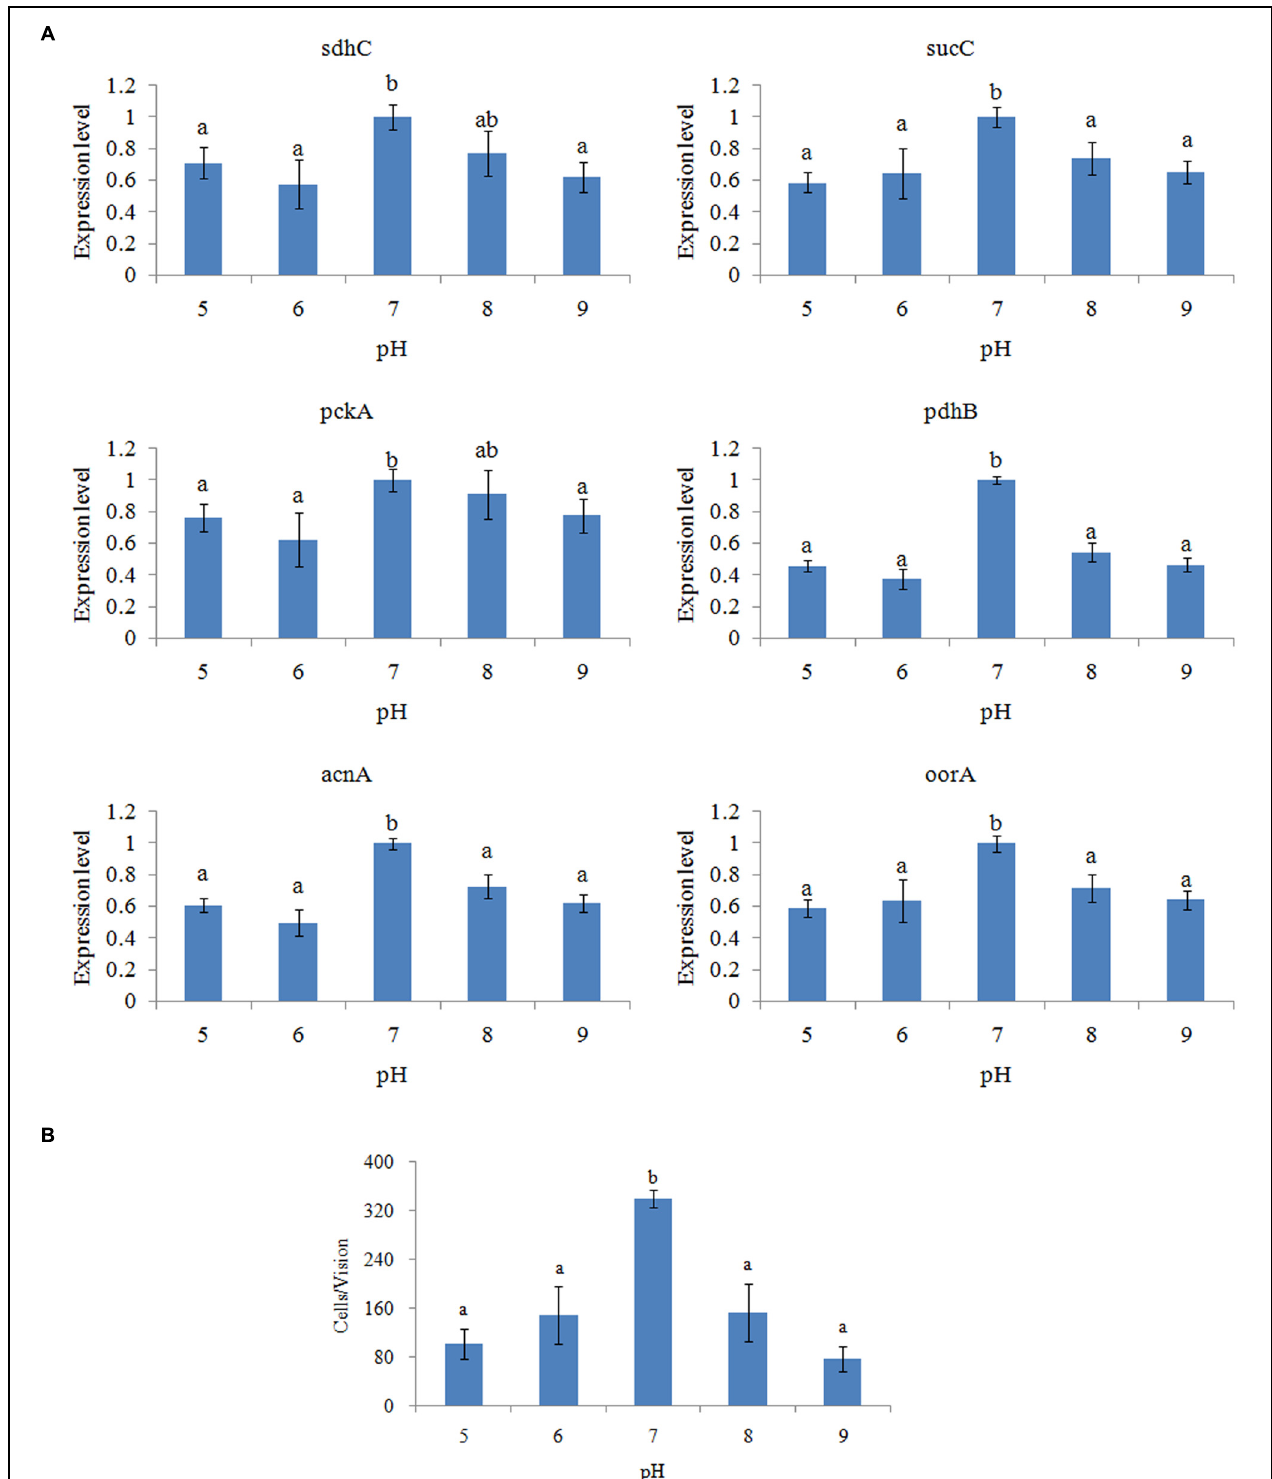
FIGURE 4 | pH affected the adhesion of V. alginolyticus . (A) qPCR analysis of the expression of sdhC , sucC , pckA , pdhB , acnA , and oorA after treated with different pH. The data are presented as the means ± SD, n = 6. The means of the treatments not sharing a common letter are significantly different at P < 0.05. (B) The adhesion capacity to mucus of V. alginolyticus cultured under different pH. The data are presented as the means ± SD, n = 3. The means of the treatments not sharing a common letter are significantly different at P < 0.05, as assessed using one-way ANOVA followed by Dunnett’s test.